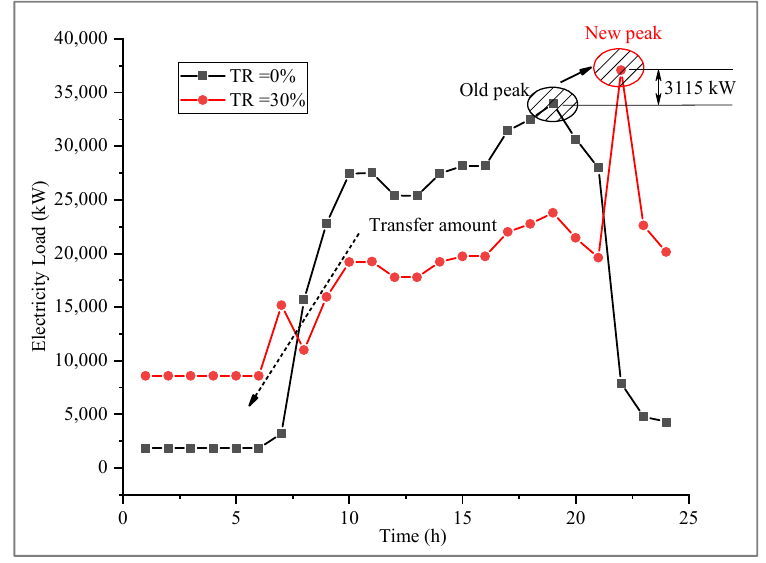
Figure 9. Peak load change due to load shift.